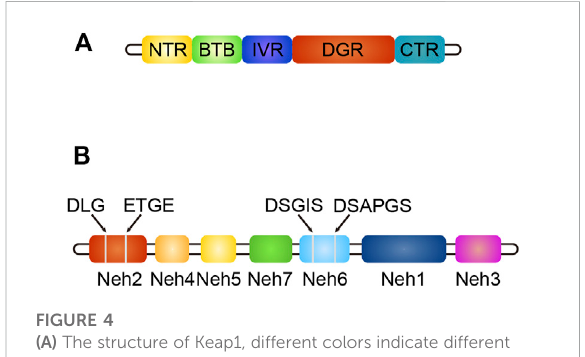
FIGURE 4 (A) The structure of Keap1, different colors indicate